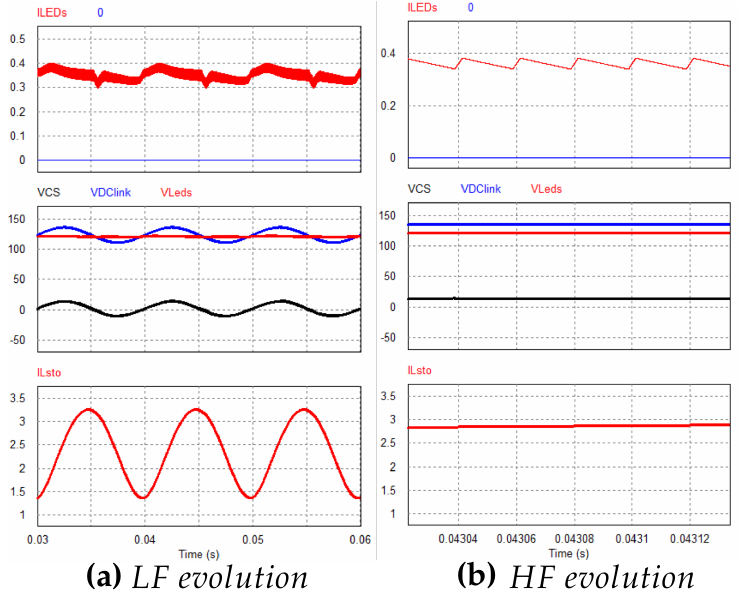
Figure 10. Simulation results for full power operation in closed loop ( L = 3 mH). Table 8. Control Parameters Design for Closed-Loop Operation with Different Inductor